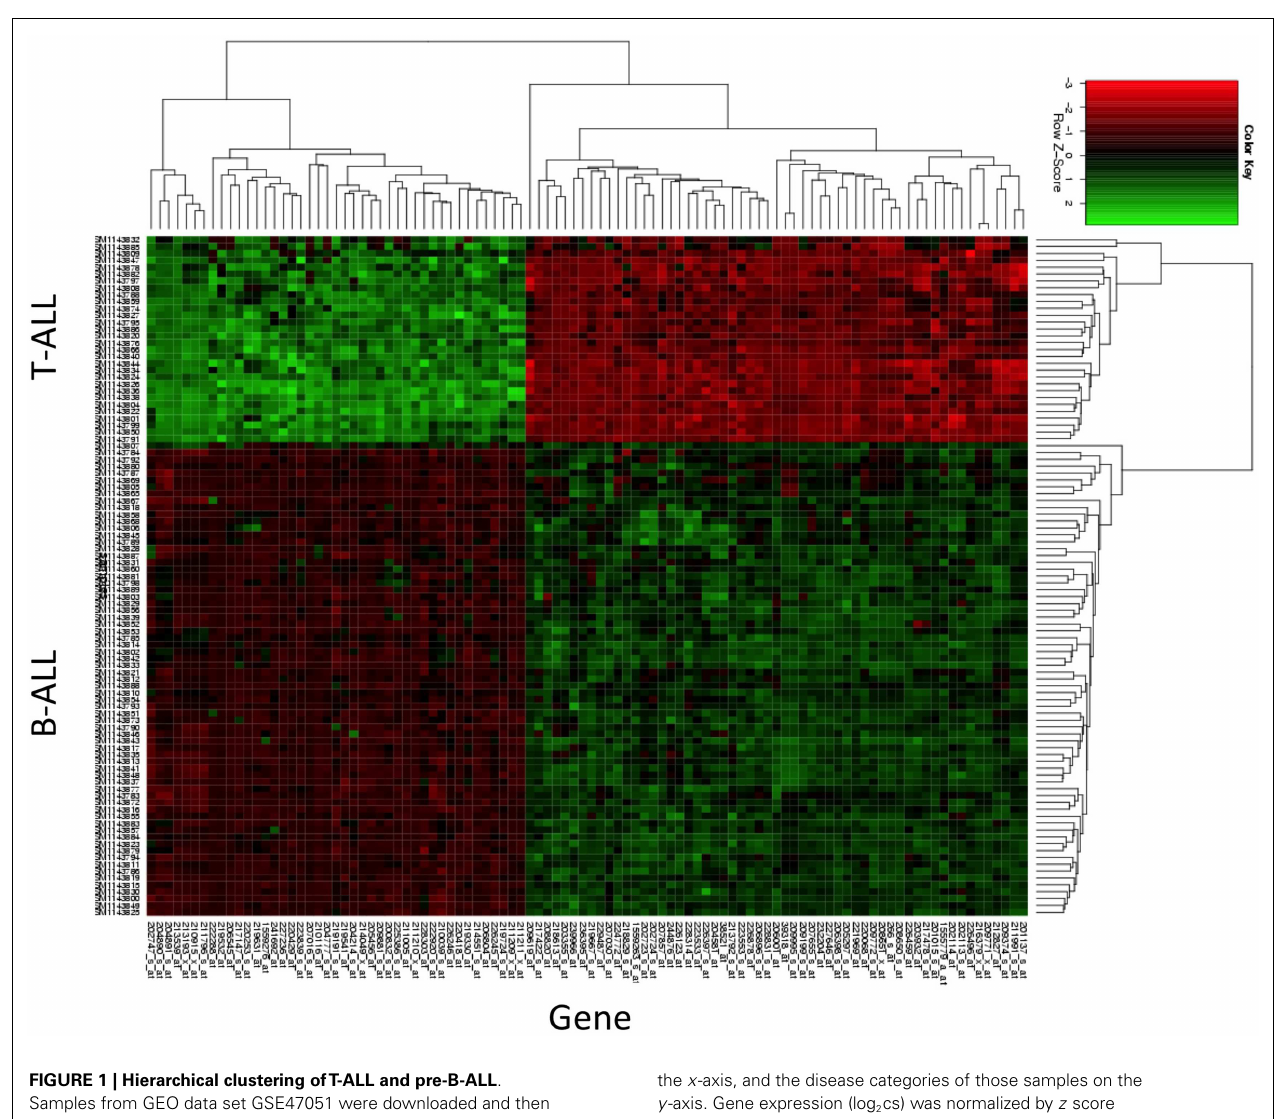
FIGURE 1 | Hierarchical clustering ofT-ALL and pre-B-ALL . Samples from GEO data set GSE47051 were downloaded and then clustered without reference to their diagnostic category (T-ALL or B-ALL).The top genes driving the subsequent clustering are listed in